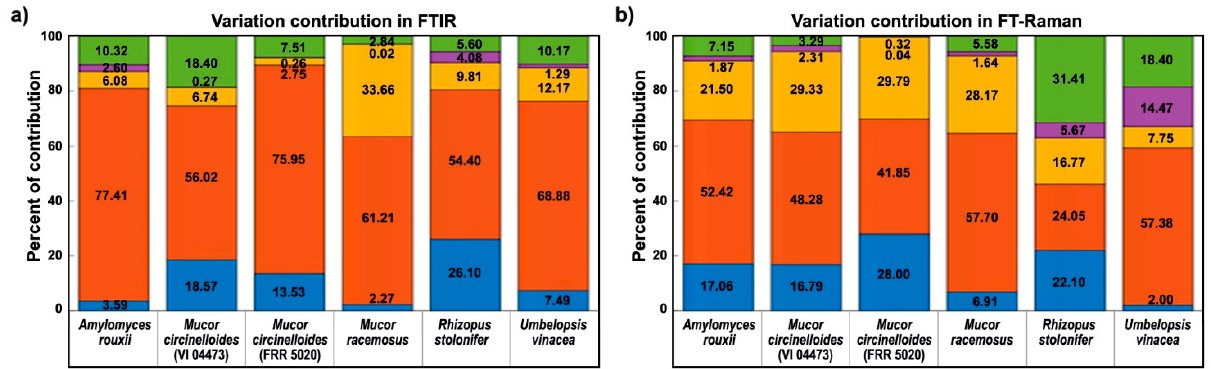
Figure 10. Variation contribution (%) of the design factors in FTIR and FT-Raman data sets. Spectral variation from calcium availability (blue), phosphates concentration (red), calcium–phosphates interaction (yellow), biological replicates (purple), and residuals (green) in: ( a ) FTIR and ( b ) FT-Raman spectral data (nonderivative data, averaged technical replicates).